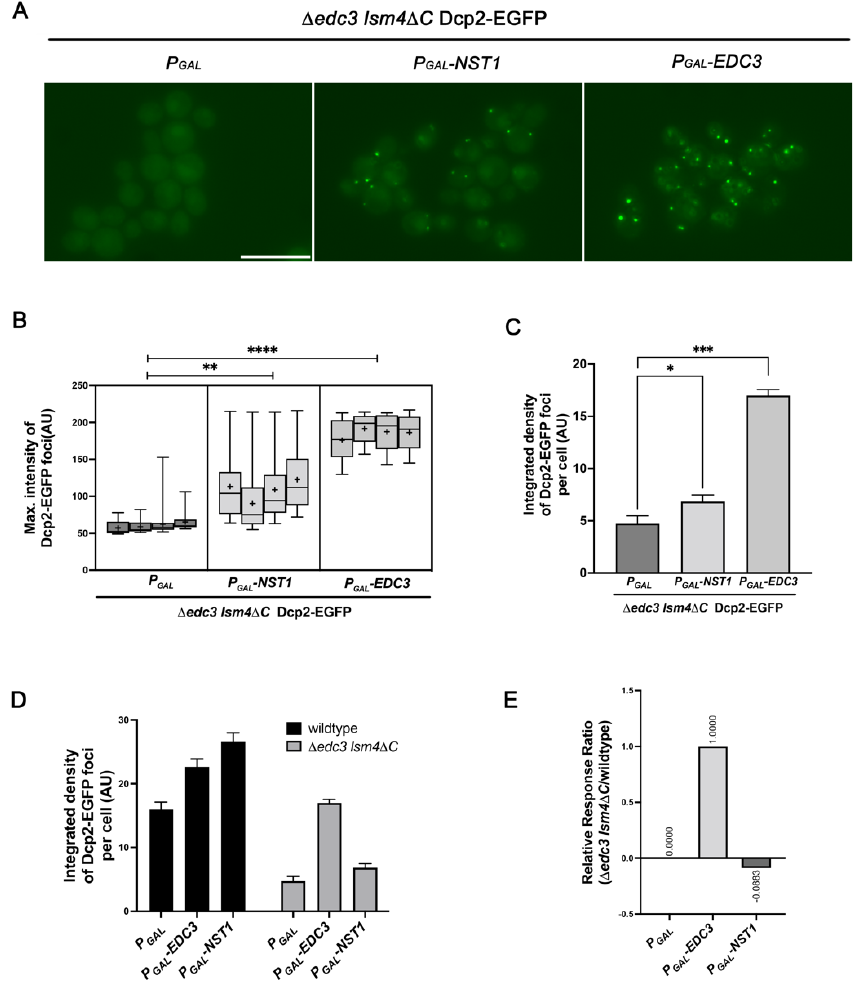
Figure 6. Overexpression of Edc3 and Nst1 induces endogenous Dcp2-EGFP accumulation in ∆ edc3 lsm4 ∆ C. Dcp2-EGFP condensation in the ∆ edc3 lsm4 ∆ C strain after induction of expression of the vector control, Nst1, and Edc3. The edc3 and lsm4 C-terminal domain double deletion mutant ( ∆ edc3 lsm4 ∆ C) , whose chromosomal DCP2 was tagged with EGFP (yRP2340), was transformed with